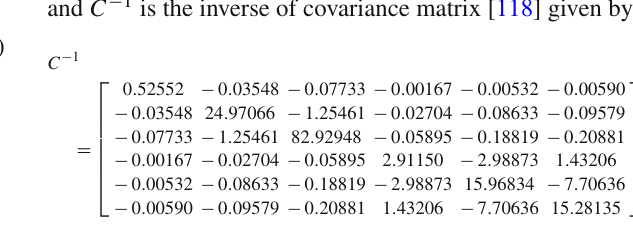
and C − 1 is the inverse of covariance matrix [118] given